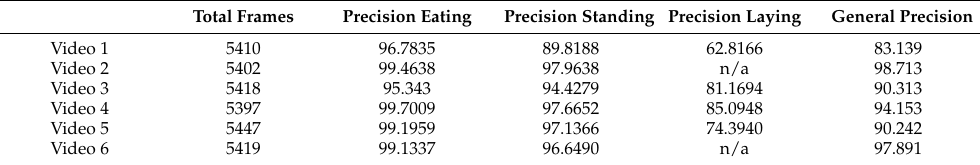
Table 4. Testing object detector.